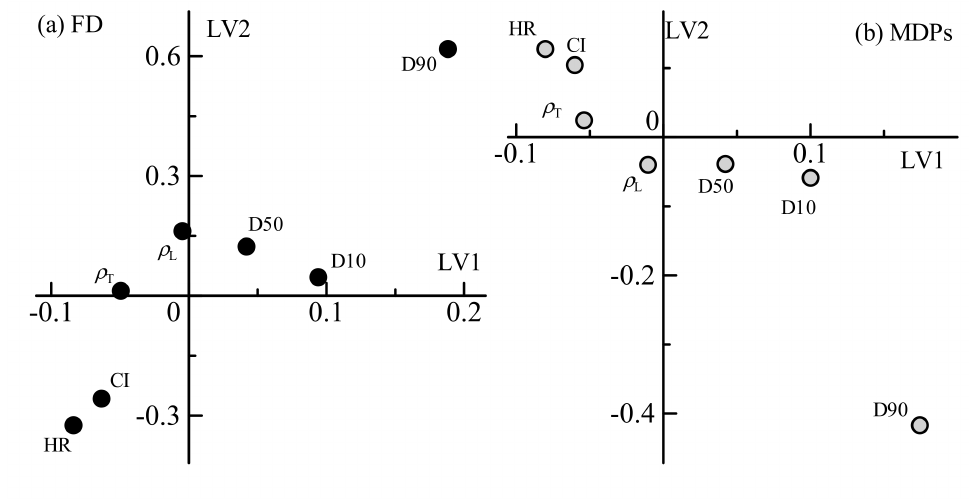
Figure 2. Loading plots of the first and second LVs in the physical attributes of granules for the control model of FD ( a ) and MDPs ( b ). HR and CI indicate the Hausner ratio and Carr index, respectively.